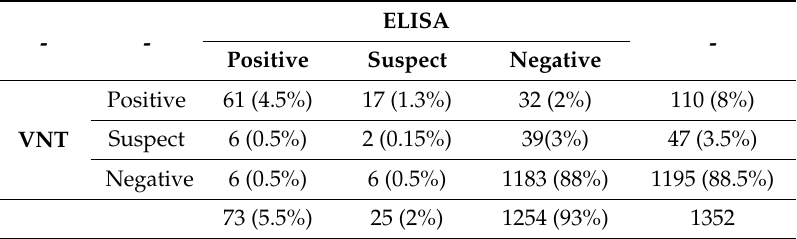
Figure 2. Number of RVF antibody positive ( A ), suspect ( B ) and negative ( C ) experimental and field sera detected by competitive ELISA and VNT. The experimental samples were constituted by sera from sows, weaners and suckling pigs, and piglets born from virus inoculated pregnant sows between dpi 0 and 61. Only discordant field sera are represented in the graphs. Table 2. Comparison of the level of agreement between the competition ELISA and VNT in Rift Valley fever (RVF) antibody status classification of experimental and field